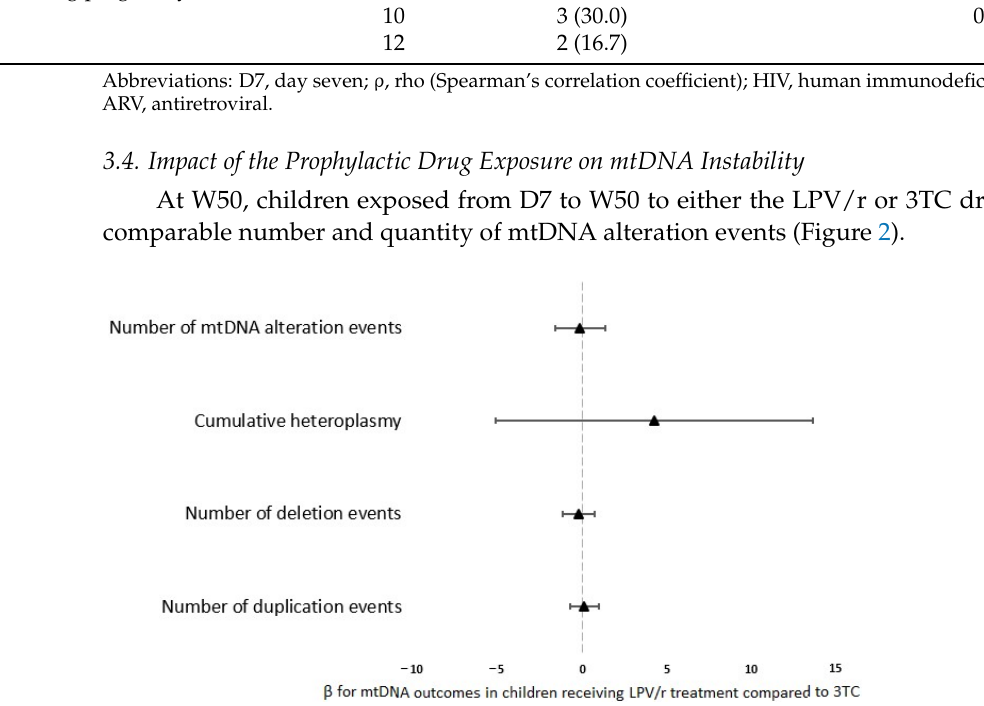
Figure 2. Forest plot of the association between LPV/r and 3TC prophylactic regimens and mtDNA alteration outcomes at W50. Regression coefficients ( β ) and their 95% confidence intervals are shown. Positive β values favor mtDNA outcomes at W50 in children receiving LPV/r treatment compared to those receiving 3TC